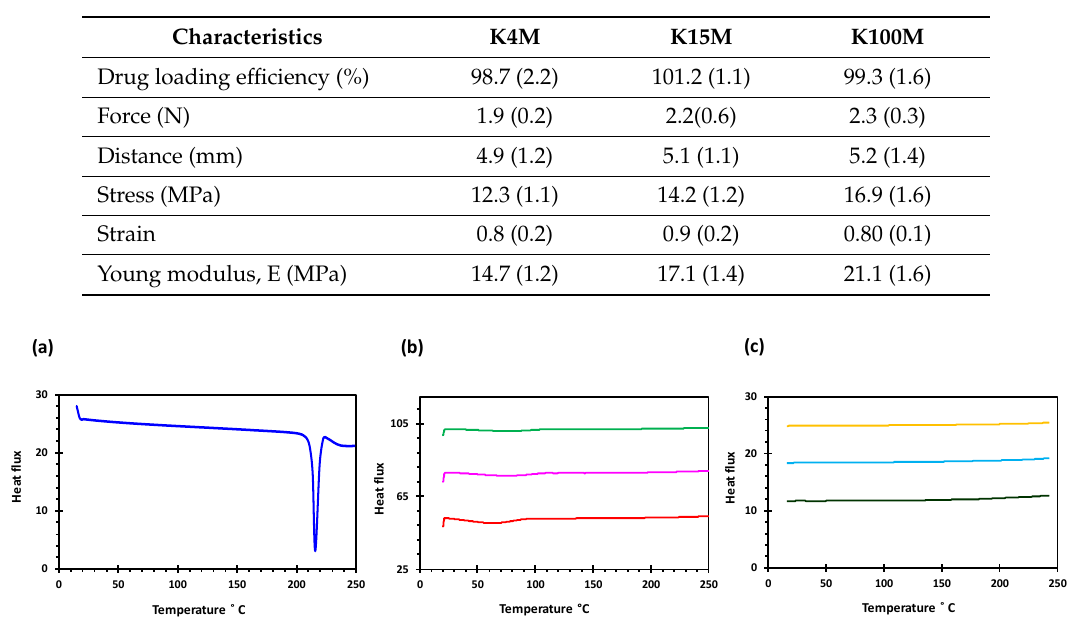
Figure 2. DSC profiles of ( a ) glipizide, ( b ) HPMC (K4M, K15M and K100M) and ( c ) K4M/GLP, K15M/GLP and K100M/GLP filaments.